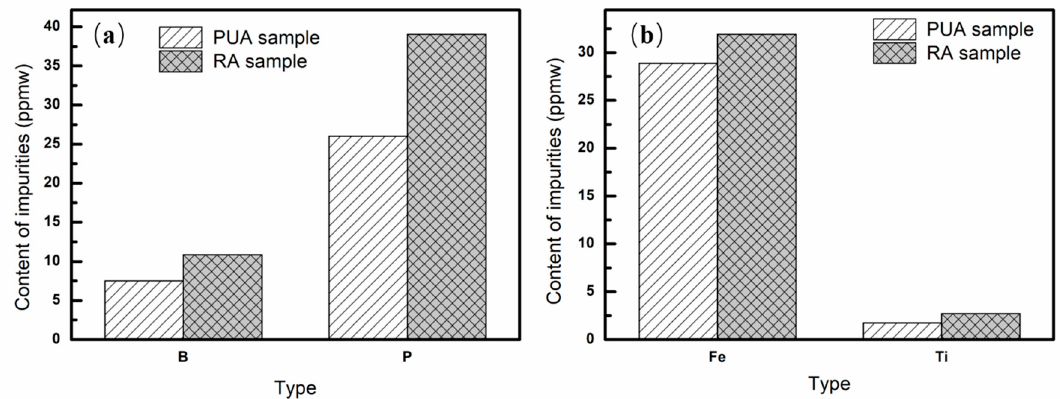
Figure 5. Content of impurities in the RA and PUA samples in Al–28%Si alloy: ( a ) B and P; ( b ) Fe and Ti.